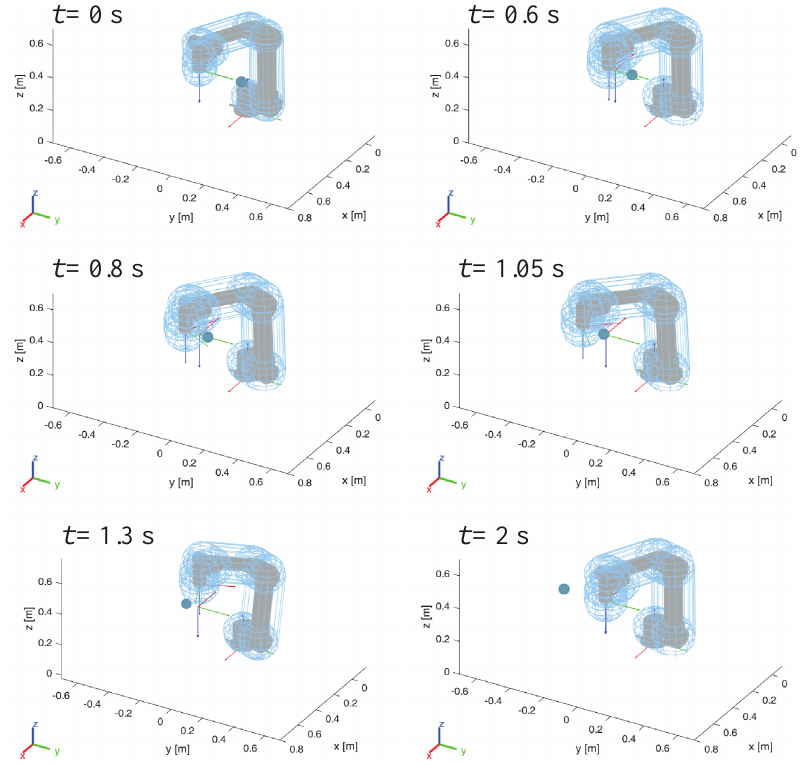
Figure 6. Avoidance of a moving obstacle interfering with the end-effector in a fixed position— mode